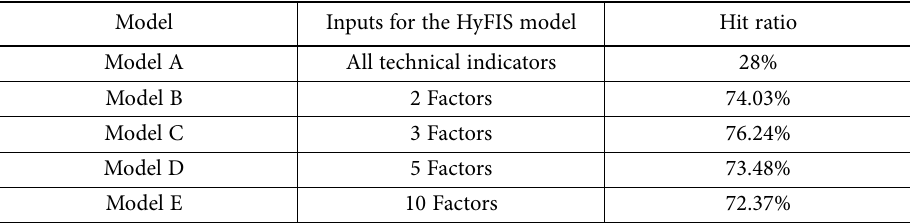
Table 3. Analysis of the hit ratio (HR) for the different prediction models